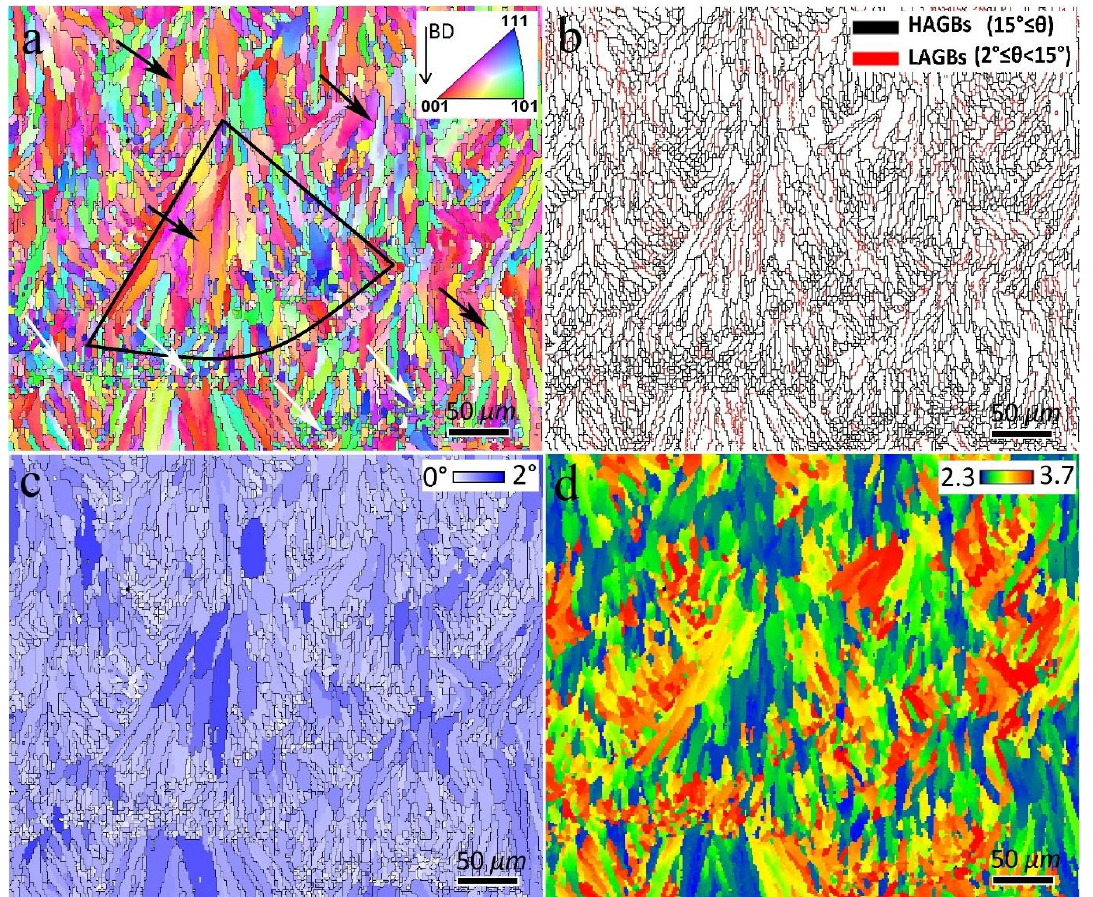
Figure 6. ( a ) Inverse pole figure (IPF), ( b ) Grain boundary (GB), ( c ) Grain average misorientation (GAM), and ( d ) Taylor factor maps of BM. In ( a , c ), HAGBs are superimposed as black boundaries. In ( d ), the {111}<110> family of slip systems was considered for calculation of Taylor factor values.